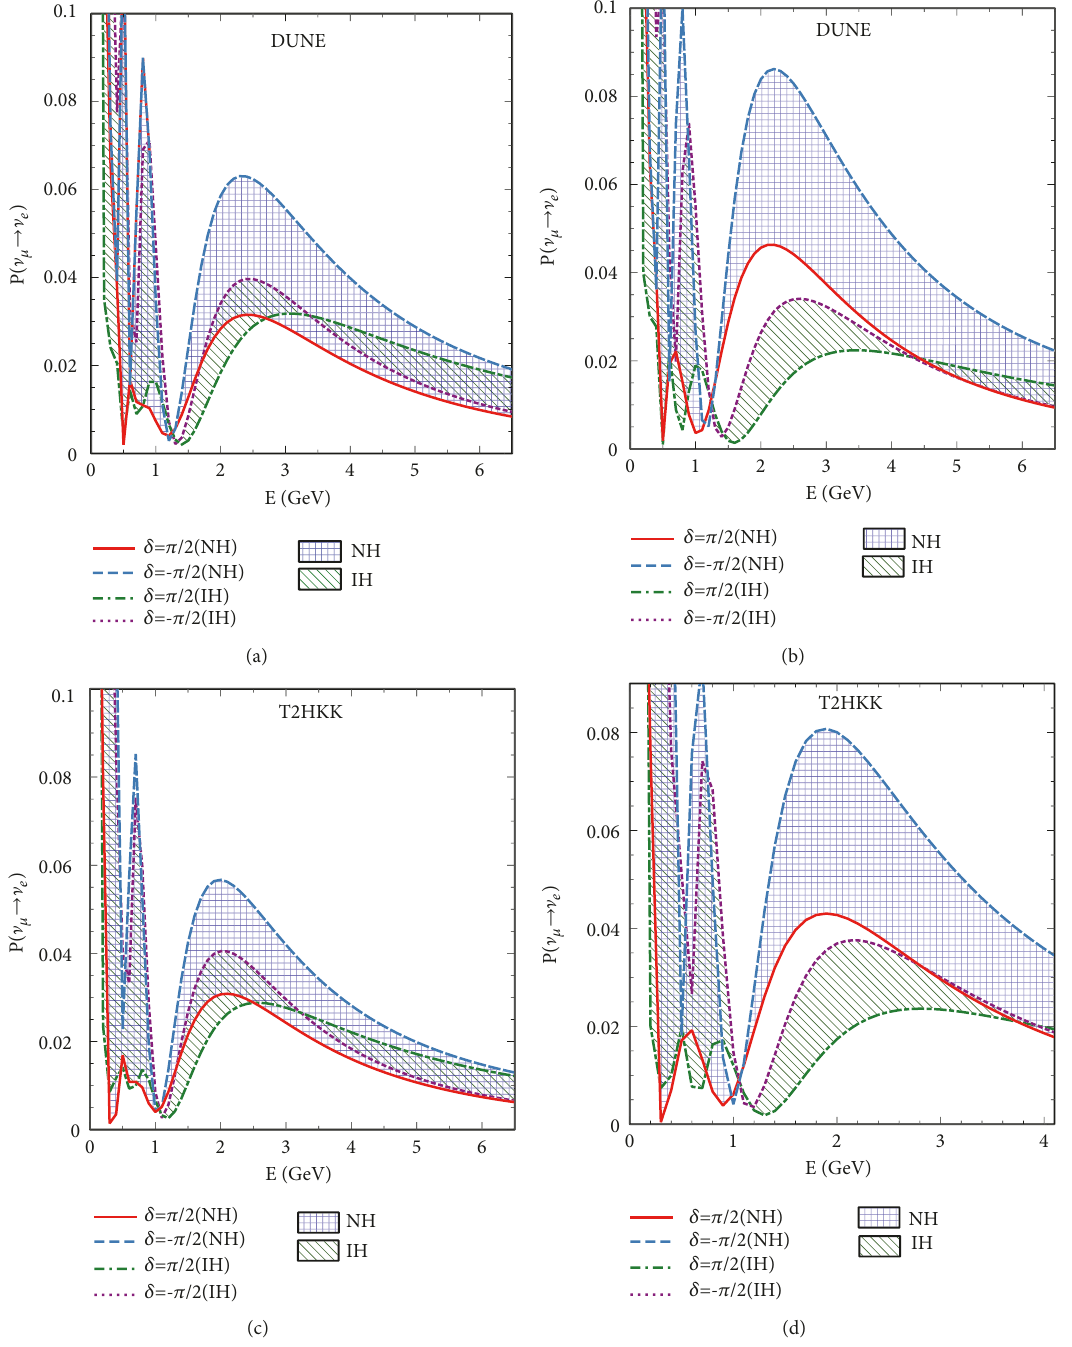
Figure 2: The appearance probability 𝑃( ] 휇 󳨀→ ] 푒 ) as function of neutrino beam energy 𝐸 for DUNE (first row) and T2HKK (second row). The left (right) panel describes mass hierarchy assuming all ( 𝜖 푒휇 ,𝛿 푒휇 ) NSI parameters nonzero. 𝜃 23 = 42 ∘ ( 𝜃 23 = 48 ∘ ) for left panel (right panel). The band comes due to variation of 𝛿,𝛿 푒휇 ∈ [−𝜋,𝜋] and boundaries correspond to 𝛿 = ±𝜋/2 for NH as well as IH.